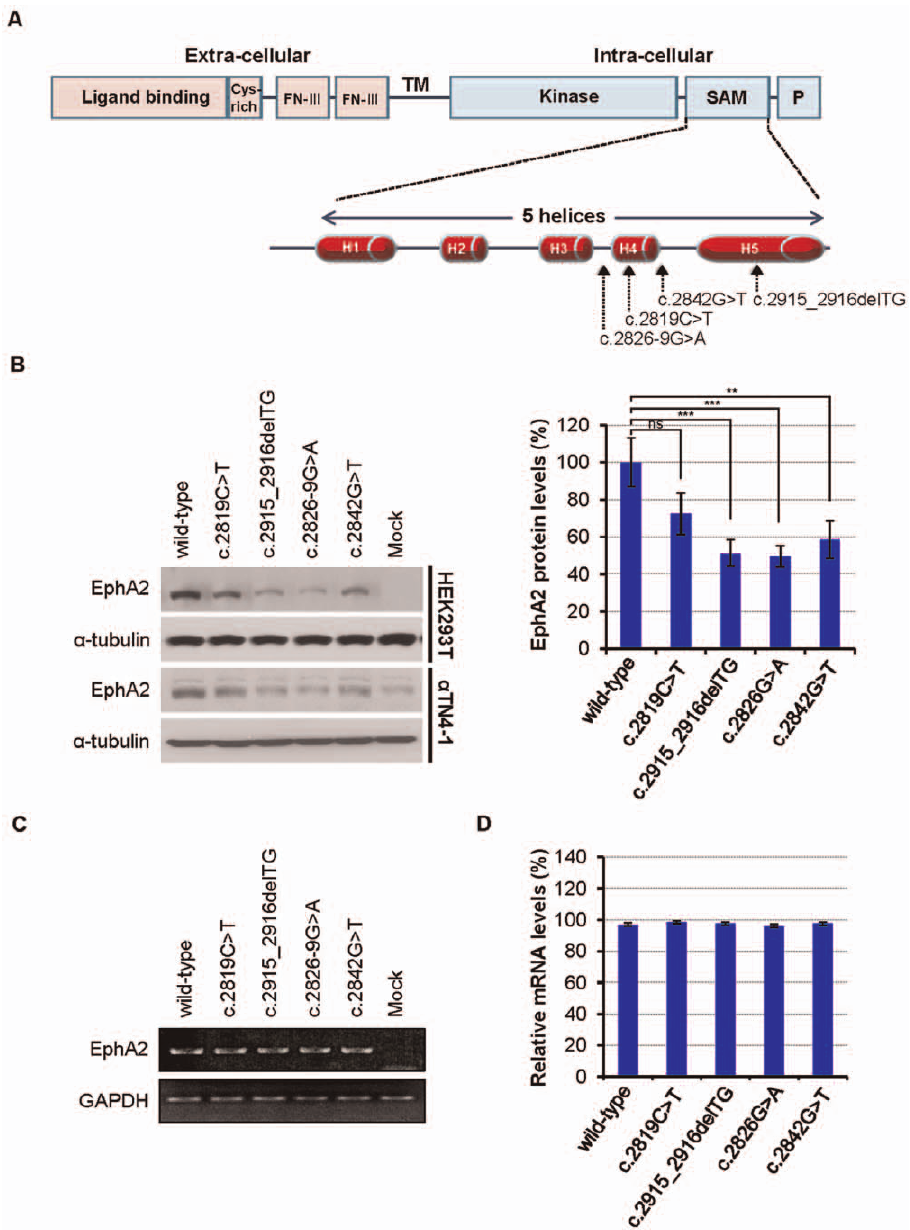
Figure 1. EPHA2 cataract mutations in the SAM domain. ( A ) Schematic diagram showing the domains of EPHA2 receptor and the locations of four SAM domain mutations found in human cataracts (c.2819C . T; c.2915_2916delTG; c.2826-9G . A; and c.2842G . T) in the EPHA2 gene. FN-III: fibronectin type-III domain; TM: transmembrane domain; Kinase: protein tyrosine kinase domain; SAM: sterile- a -motif domain; P: PDZ-binding motif. The SAM domain comprises 5 a -hecices (H1–5). ( B ) Reduction of mutant EPHA2 protein levels in transfected cells expressing EPHA2 mutants. Protein levels of EPHA2 mutants are decreased in both HEK293T and a TN4-1 cells. The blot was reprobed with anti- a -tubulin as a loading control. The graphs represent the quantification of relative band intensity of EphA2 as connected by the levels of a -tubulin from three independent experiments. Total EphA2 protein band intensity was determined using ImageJ software. Mean values are presented with + S.D as indicated. Statistical differences between multiple groups were analyzed using one-way analysis of variance (ANOVA). ***, P , 0.001; **, P , 0.01; *, P , 0.05; and ns, not significant. Values of P , 0.05 were considered to be statistically significant. ( C, D ) No difference between wild-type and mutant EPHA2 genes in transcription levels. ( C ) Semi-quantitative RT-PCR and ( D ) Real-time PCR for wild-type and mutant EPHA2 genes were performed using total RNA, isolated from transfected HEK293T cells. GAPDH transcript levels are used as controls. The graphs represent the quantification of western blots from three independent experiments.